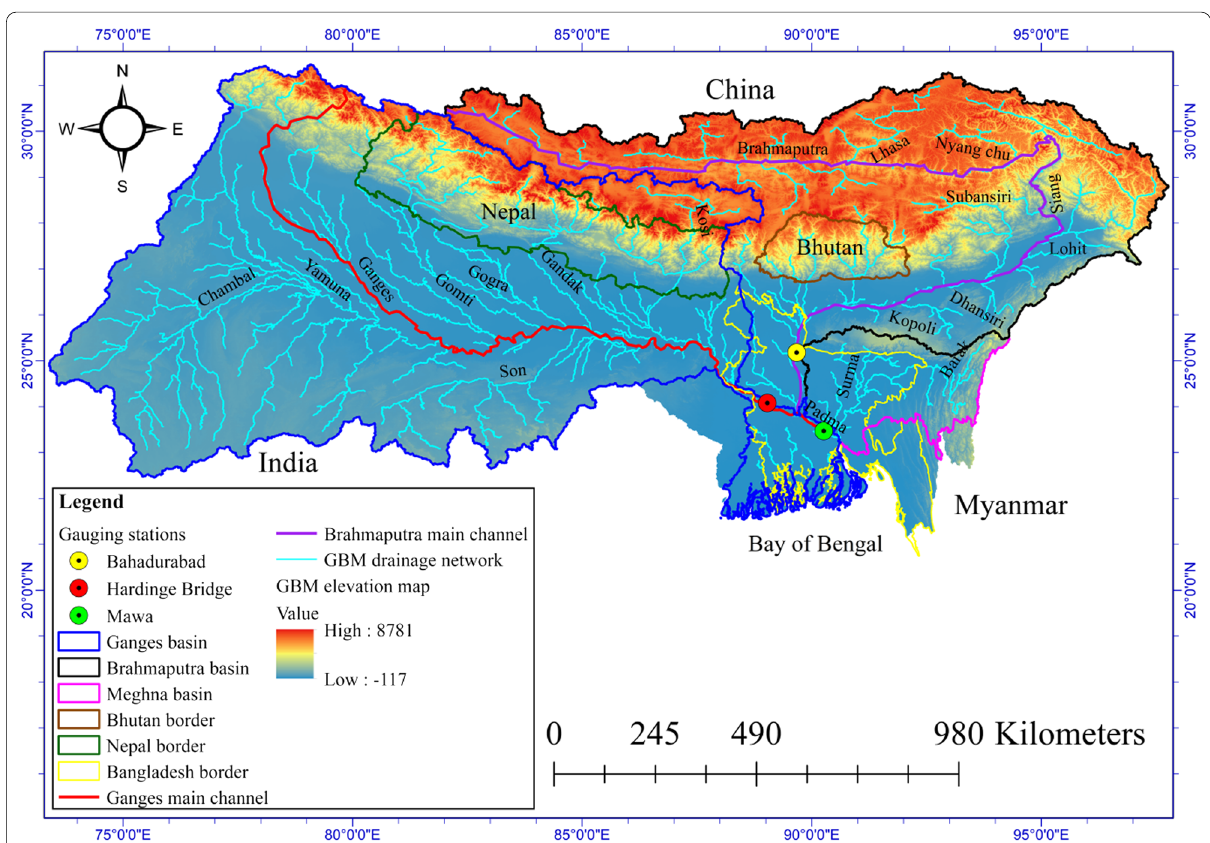
Fig. 3 GBM river basin elevation and drainage network. The elevation is prepared based on NASA-DEM (30 m resolution). The yellow, red, and green circles denote the in situ gauging stations for discharge